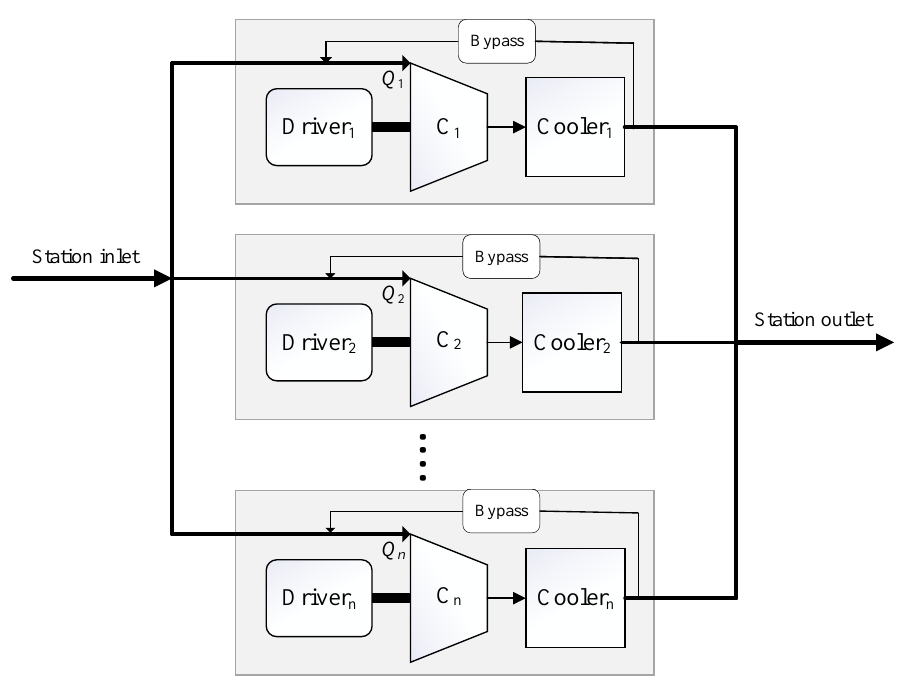
Figure 1. Natural gas compressor station with parallel